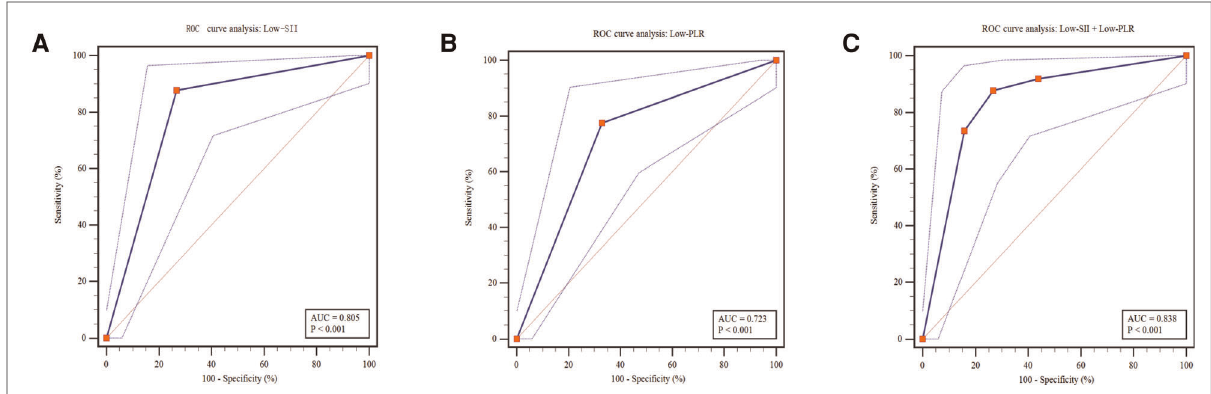
FIGURE 4 Predictive assessment of Low-SII, Low-PLR and both for patients receiving surgery with ROC curve analysis. ROC, receiver operating characteristics; AUC, area under the curve; SII, systemic immune-in fl ammation index; PLR, platelet-to-lymphocyte ratio.